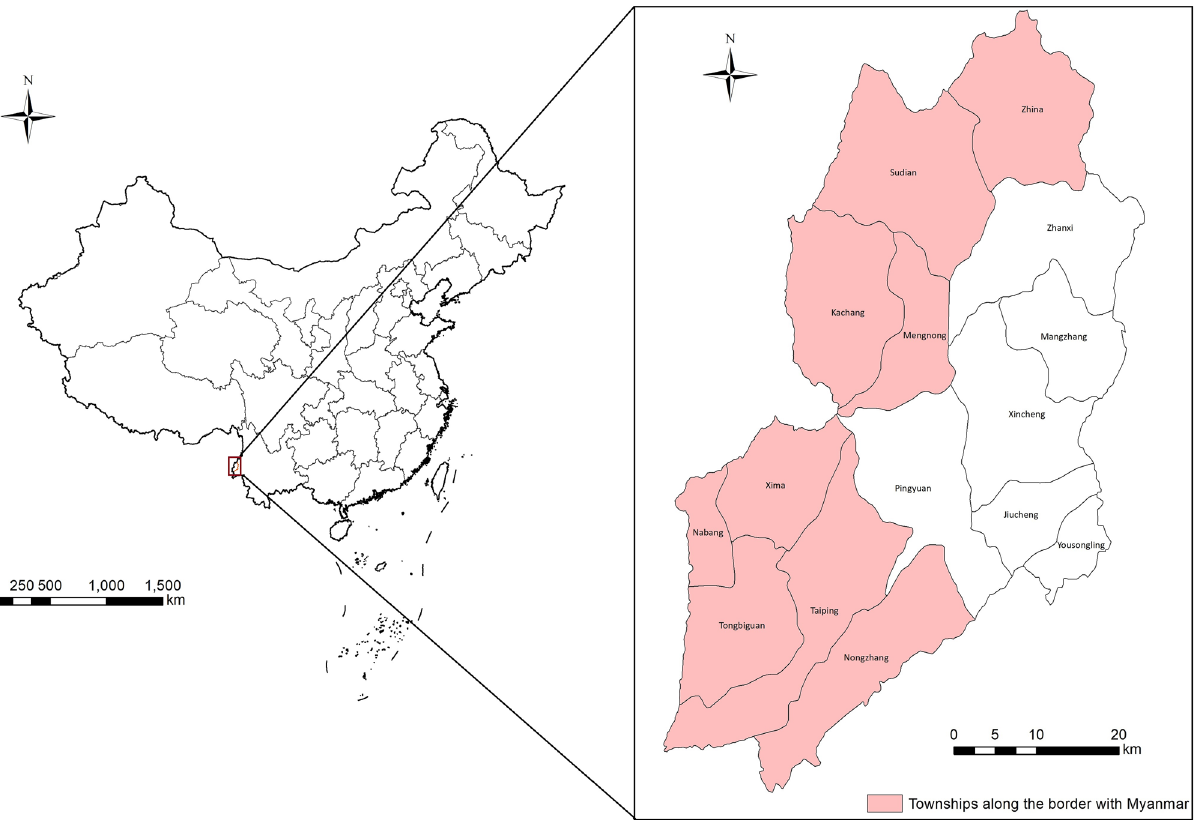
Figure 4. Location of Yingjiang County and the townships along the China–Myanmar border. A total of 15 townships were included in Yingjiang County, nine of which borders Myanmar shown with light red color. Maps were created by the first author (FH) working with ArcGIS version 10.1, https:// www. arcgis.